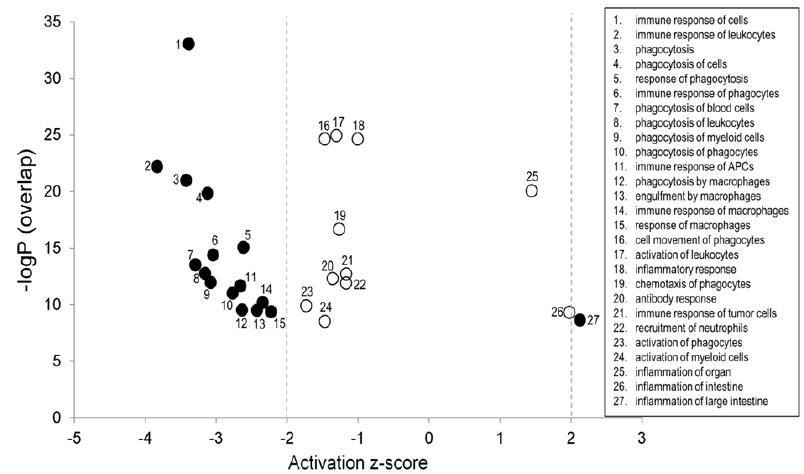
Figure 4. Overrepresentation analysis of inflammatory response ‐ related bio ‐ functions, using Ingenuity Pathway Analysis. A total of 27 sub ‐ functions, under the broader category of inflammatory response, were identified from the data. Results are based on gene expression changes in Q ‐ mix vs. placebo. The extent of pathway overrepresentation is shown via the negative logarithm of the overlap p ‐ value ( y ‐ axis), and consistency of gene expression changes are shown via the z ‐ score ( x ‐ axis). The dashed lines mark z ‐ scores ≤− 2.0 or ≥ 2.0, indicative of inhibited and activated sub ‐ functions, respectively (filled circles). Sub ‐ functions are numbered and described in the accompanying legend.